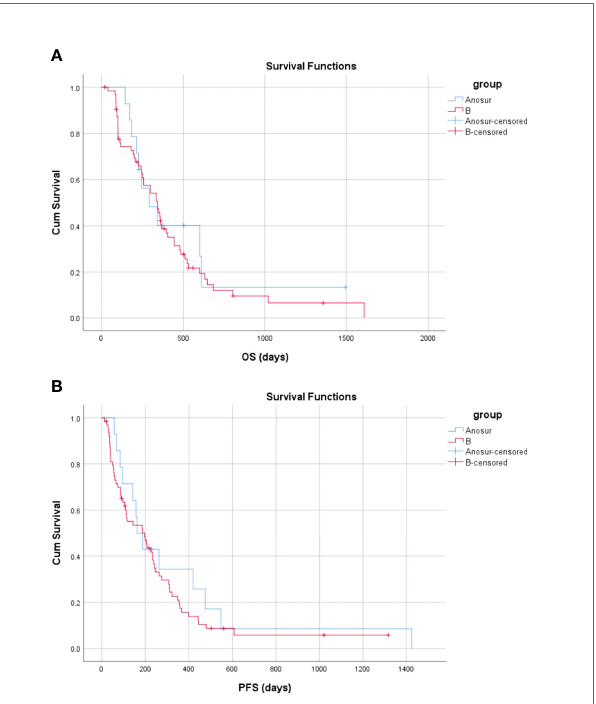
FIGURE 8 | Overall and progression-free survival between Group A NoSur and Group B (A) The OS in Group A NoSur and Group B (B) The PFS in the no operative Group A NoSur and Group